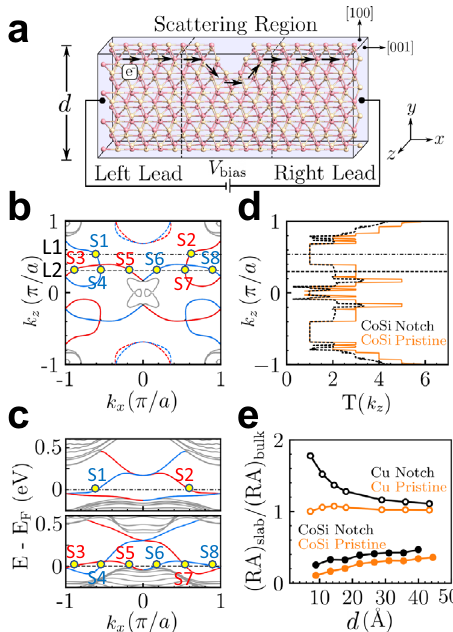
Fig. 2 First-principles informed quantum transport in CoSi slabs. a Schematic view of a two-terminal device with a scattering region composed of a CoSi slab of thickness d along the [100] direction, sandwiched between two semi-in fi nite CoSi leads. An external bias- voltage V bias (cid:3) E F = e (with e the electron ’ s charge) injects a charge current in the [001] direction. The arrows illustrate the surface current distribution on the top surface in the presence of defects (shown as a notch). b Fermi surface of a 40AL CoSi slab with d = 36.05 Å. Fermi-arc surface states on the top and bottom surfaces are denoted in red and blue solid lines, respectively. The dashed lines indicate the topologically trivial surface states, while the gray lines indicate the bulk states. c Top panel: band structure of the same slab along the linecut L1 in b at k z ¼ 0 : 52 π = a ð Þ (cid:4) k z 1 , revealing the Fermi-arc surface states (in blue and red) connecting between the bulk valence and conduction bands (in gray). The markers S 1 and S 2 in b and c indicate the conducting channels available for transport at a fi xed k z 1 . Bottom panel: band structure of the slab along the linecut L2 in b at k z ¼ 0 : 3 π = a ð Þ (cid:4) k z 2 . The markers S i ( i = 3 to 8) indicate the conducting channels available for transport at k z 2 . d , k z -resolved transmission T k z ð Þ for a pristine 40 AL CoSi slab, compared to that for a slab with a notch on the top surface. e Thickness dependence of the resistance-area (RA) product of Cu and CoSi slabs, normalized by the RA product in the in fi nite thickness limit, denoted as (RA) bulk . The orange curves represent pristine slabs, while the black curves represent slabs with surface disorder in the form of a notch on the top surface. We note that (RA) slab /(RA) bulk is equivalent to the normalized resistivity ( ρ = ρ 0 ) as the channel length is fi xed in the simulations of the same per spin. For example, along k z ¼ 0 : 3 π = a (L2 in Fig. 2b), there are three states on the top (S3, S5, and S7) and bottom (S4, S6, and S8) surfaces, respectively. Just as S1 and S2, the states related by a C2 rotation along the z -axis (e.g., S4 and S7) are located on opposite surfaces and cannot backscatter among each other. Nevertheless, S4 can backscatter to S8. Therefore, scattering off a line defect does reduce T (e.g., from 3 to ~2 at k z ¼ 0 : 3 π = a ), but T ð k z Þ remains larger than one because band topology guarantees an extra forward-moving surface mode for transport. This protected Fermi-arc transmission can be seen in CoSi slabs with various types of line defects (Supplementary Fig. 3). Figure 2e shows how the Fermi-arc states impact the scaling of resistance-area (RA) product. The number of Fermi-arc channels remains nearly constant with decreasing fi lm thickness, and, at the nanoscale, surface conduction dominates over bulk conduction.